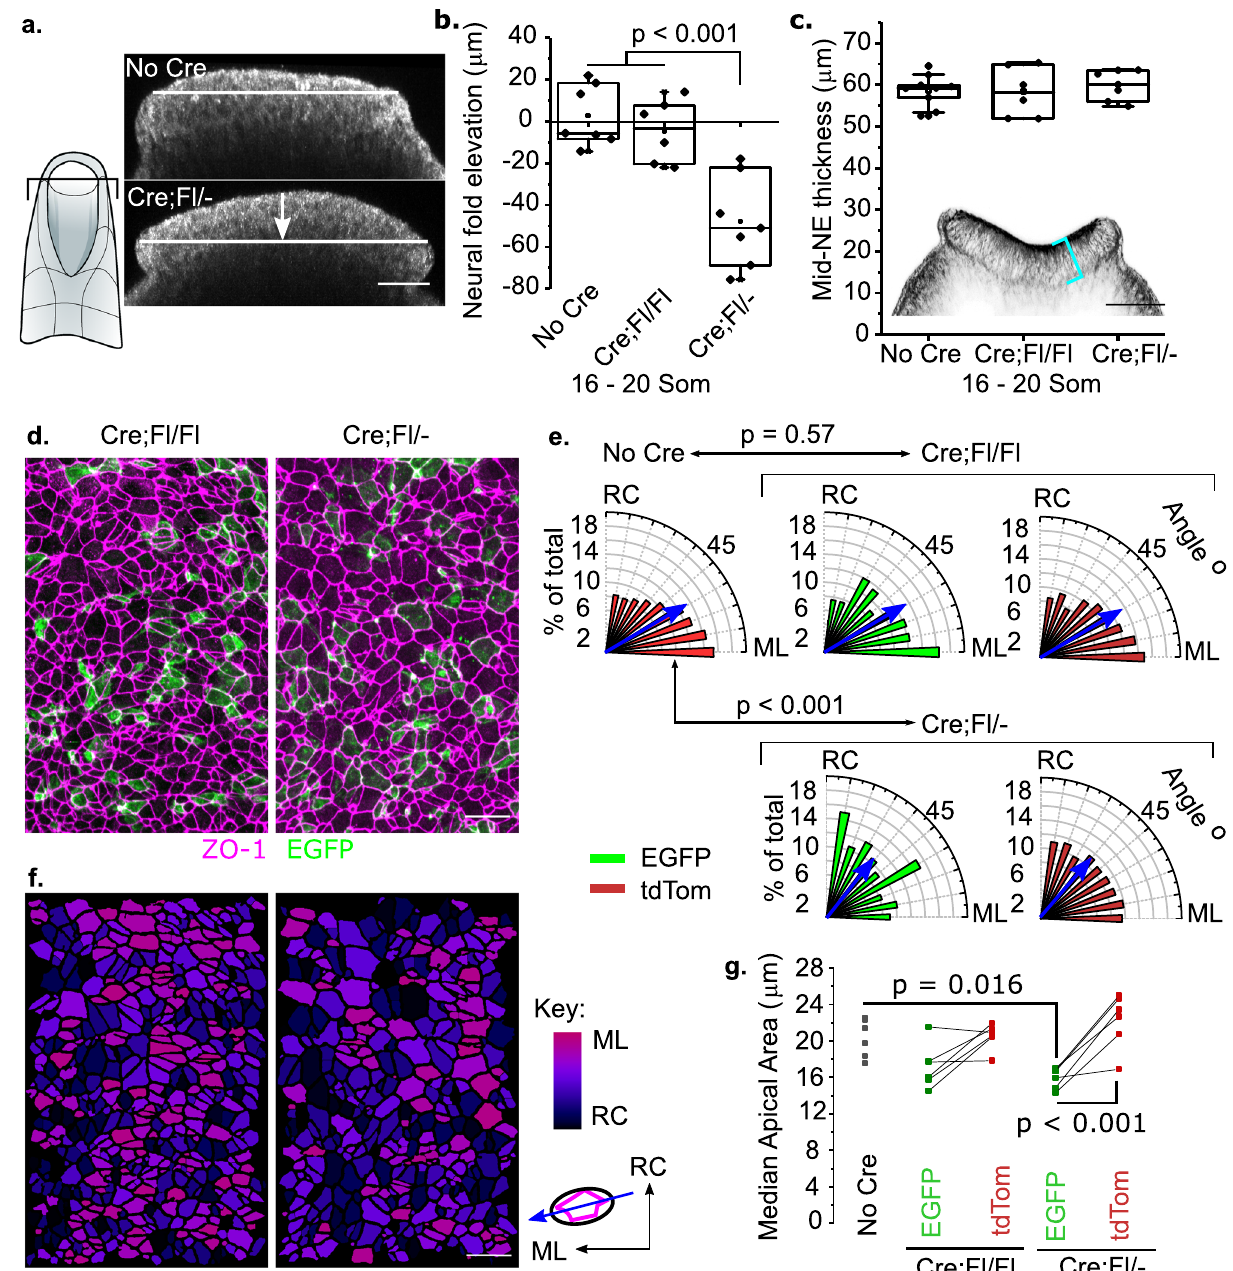
Fig. 2 Mosaic Vangl2 deletion disrupts planar polarised neuroepithelial apical orientation. a Optical cross-sections through the caudal PNP (at 75% of rostrocaudal PNP length, shown in schematic) of No Cre and Cre;Fl/ − embryos at E9.5, visualised using re fl ection imaging. The white arrow indicates the quanti fi ed eversion of the apical neuroepithelium, which should elevate its lateral margins to form neural folds. Scale = 50 µ m. b , c Quanti fi cation of neural fold elevation ( b , positive values) or eversion ( b , negative values) and mid-PNP neuroepithelial thickness ( c ) in control, Cre;Fl/Fl and Cre;Fl/ − embryos at 16 – 20 somite stages, before the PNP is signi fi cantly longer in Cre;Fl/ − embryos. The inset shows an optical cross-section through a phalloidin-stained PNP indicating the thickness of the neuroepithelium (cyan bracket). b Control = 7, Cre;Fl/Fl = 6, Cre;Fl/ − = 7 embryos. c Control = 9, Cre;Fl/Fl = 6, Cre;Fl/ − = 7 embryos. Scale = 50 µ m. d Representative (>6 embryos) surface-subtracted images of the apical neuroepithelium in a Cre;Fl/Fl embryo and Cre;Fl/ − littermate showing the apical marker ZO1 and recombined cells lineage traced with EGFP. Scale = 20 µ m. e Quanti fi cation of the orientation of the apical long axis of neuroepithelial cells in No Cre, Cre;Fl/Fl and Cre;Fl/ − embryos. Blue arrows indicate the median orientation; p values from Chi 2 with Yates continuity correction; EGFP and tdTom not signi fi cantly different within genotypes. No Cre 5592 cells from six embryos; Cre;Fl/Fl EGFP/tdTom 318/2373 cells from fi ve embryos; Cre;Fl/ − EGFP/tdTom 267/3799 cells from six embryos. RC rostrocaudal, ML mediolateral. f Apical surfaces from d colour coded to illustrate orientation. Bright colours indicate medio-lateral, dark colours indicate rostro-caudal orientation. Scale = 50 µ m. g Quanti fi cation of neuroepithelial apical area. Each point represents the median value for an embryo and lines link points from the same embryo, n = 6 embryos per genotype. p values from ANOVA with post-hoc Bonferroni. Embryos compared had 15 – 20 somites and had been administered tamoxifen 24 – 28 h prior to